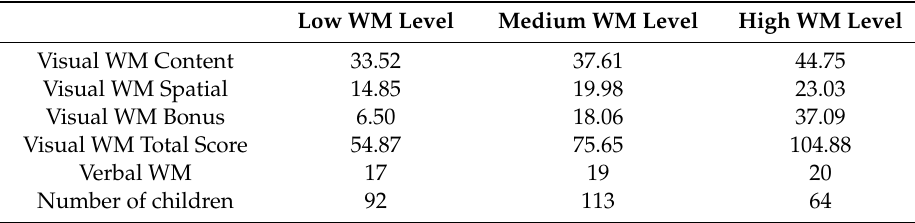
Table 2. Final centers of clusters based on the success of the children performing the working memory (WM) tests.